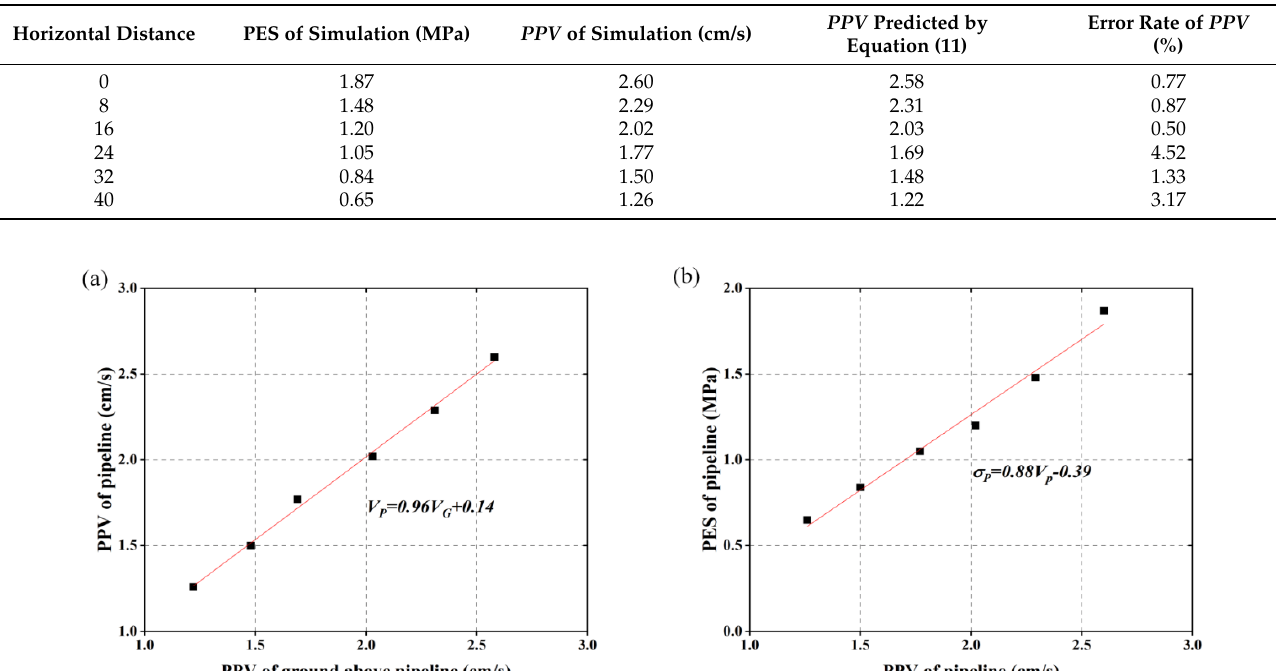
Table 9. Simulation data and predicted results.